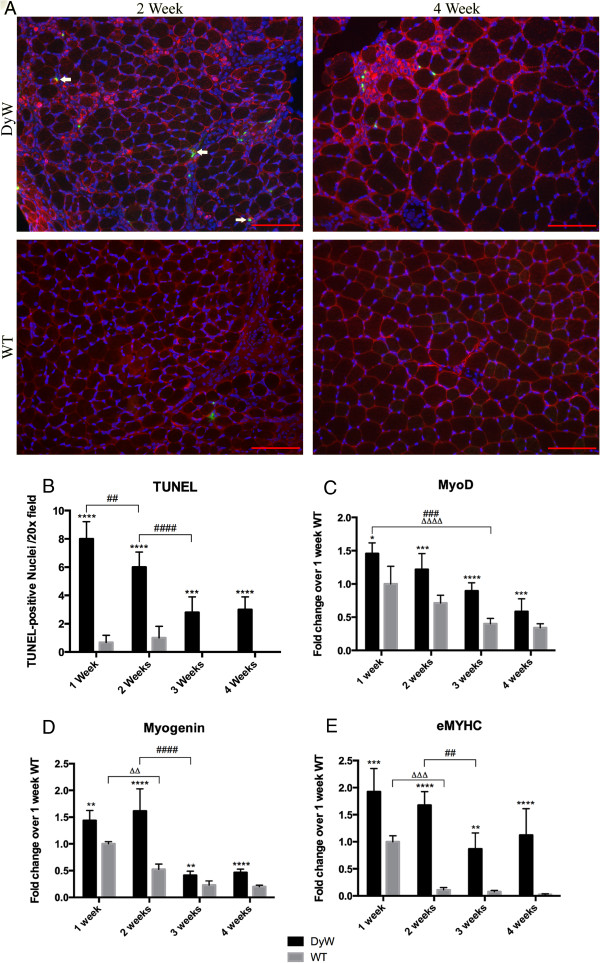
Gene expression analysis using quantitative RT-PCR, along with TUNEL immunostaining, show an increase in the myogenic program and cell death. (A) Terminal deoxynucleotidyl transferase 2′-deoxyuridine-5′-triphosphate nick-end labeling (TUNEL) staining shows an increased number of apoptotic nuclei in Lama2DyW (DyW) muscles at each of the four time points. Desmin costaining was used to delineate differentiated myogenic cells. Arrows point to those cells that are both desmin-positive (red) and TUNEL-positive (green). (DyW is also referred to as KO, Knockout.) (B) Quantitative analysis of the TUNEL staining shows the highest incidence of apoptosis at postnatal week 1, which decreased by 50% at week 3. (C) Gene analysis of MyoD shows the highest expression for both groups early in life, followed by decreases over time. DyW mice had significantly increased expression compared to age-matched wild-type (WT) mice at all time points (1 week: P < 0.05, 2 weeks: P < 0.001, 3 weeks: P < 0.0001 and 4 weeks: P < 0.001, all by two-way analysis of variance (ANOVA) (n = 5 for all groups). (D) Myogenin expression shows a similar trend of having the highest expression early on, and DyW levels were also increased compared to all age-matched WT groups (1 week: P < 0.01, 2 weeks: P < 0.0001, 3 weeks: P < 0.005 and 4 weeks: P < 0.0001, all by two-way ANOVA (n = 5 for all groups). (E) Embryonic myosin heavy chain (eMYHC) expression was significantly elevated in the DyW mice at each of the four time points (1 week: P < 0.0005, 2 weeks: P < 0.0001, 3 weeks: P < 0.005 and 4 weeks: P < 0.0001, all by two-way ANOVA (n = 5). Asterisks indicate statistical significance between age-matched DyW and WT animals, hash tags indicate significant changes within the DyW group and Deltas indicate significant changes within the WT group. *P < 0.05, **P < 0.01, ***P < 0.001 and ****P < 0.0001. These statistical representations also apply other symbols (Δ, #). Bar = 100 μm.